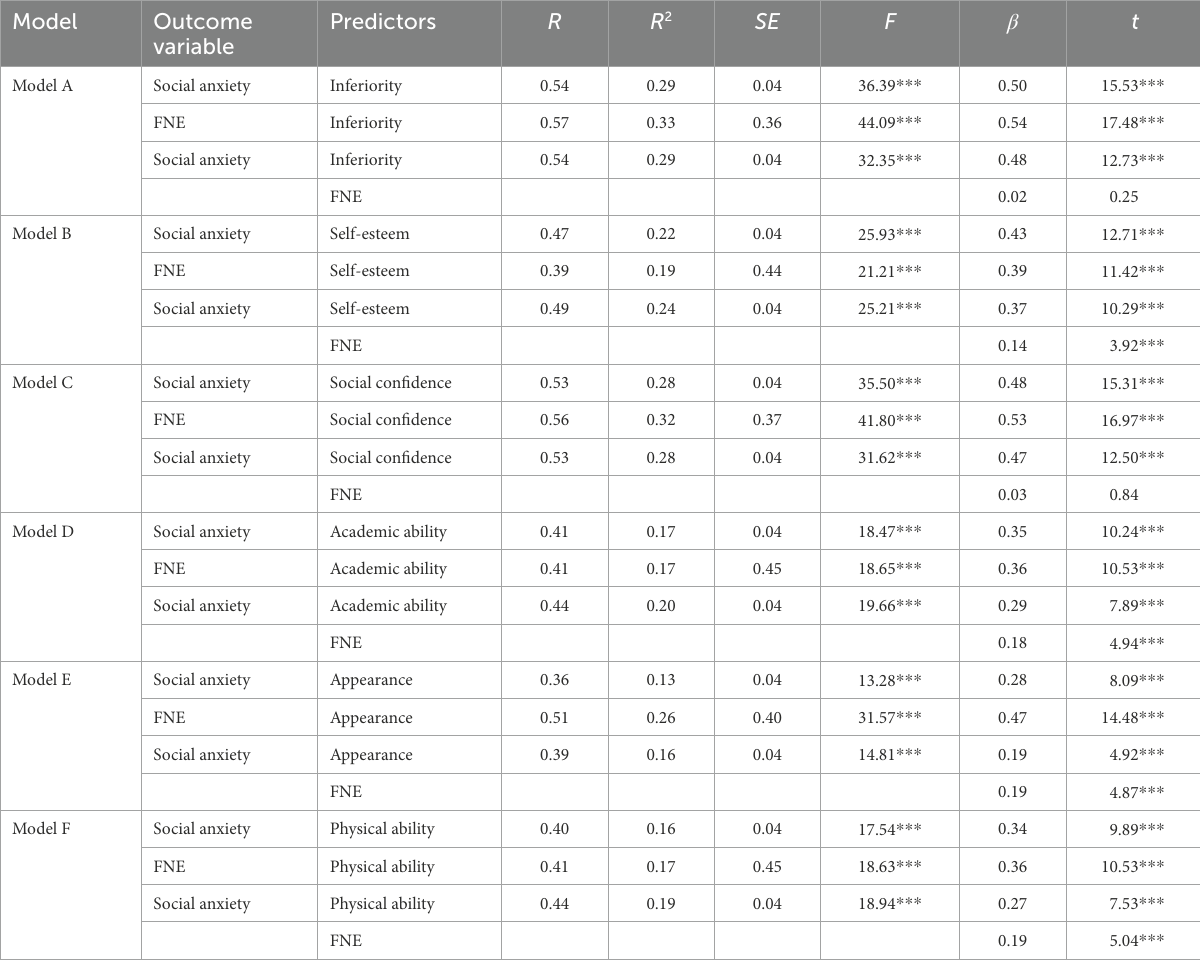
TABLE 3 Mediation effect of FNE on the relationship between inferiority and social anxiety. Model